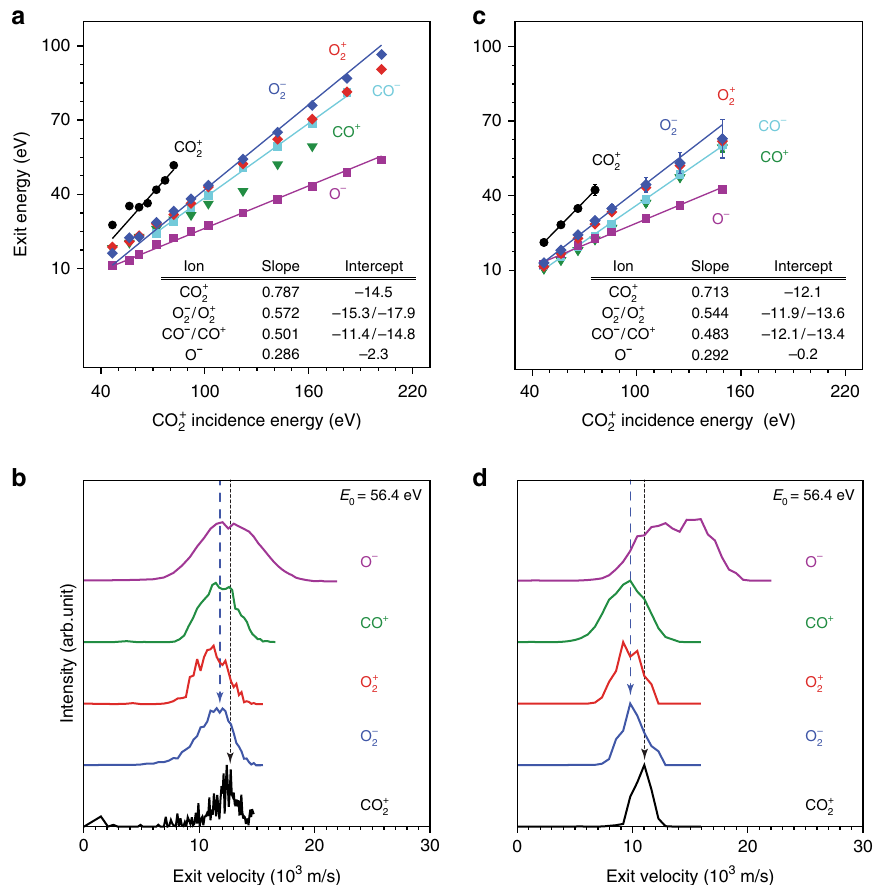
Fig. 2 Kinematics and velocity analysis of CO 2 + scattering on Au. a Experimental exit energies of CO 2 + , O 2 + , O 2 − , CO + , CO − , and O − ions from CO 2 /Au collisions as a function of CO 2 + incidence energy. All points represent the peak of the respective energy distribution obtained from Gaussian fi tting of the experimental data. All solid lines represent one-parameter linear fi ttings with BCT-derived slopes. No fi ttings are shown for O 2 + and CO + data because of overlap with their negative ion counterparts. b Experimental velocity distributions of select scattered product ions for E 0 = 56.4 ± 2.5 eV. c Calculated exit energies of CO 2 + , O 2 + , O 2 − , CO + , CO − , and O − ions from MD simulations of CO 2 /Au collisions as a function of CO 2 + incidence energy; slopes and intercepts listed in the inset are two-parameter best- fi ttings. The error bars represent one standard deviation across 10 samples of 2000 trajectories each from the ensemble of molecular dynamics trajectories. d Calculated velocity distributions from MD simulations for select scattered ion products at E 0 = 56.4 eV. Vertical dashed lines in ( b ) and ( d ) indicate alignment with respect to the CO 2 + (dashed black line) and O 2 − (dashed blue line)